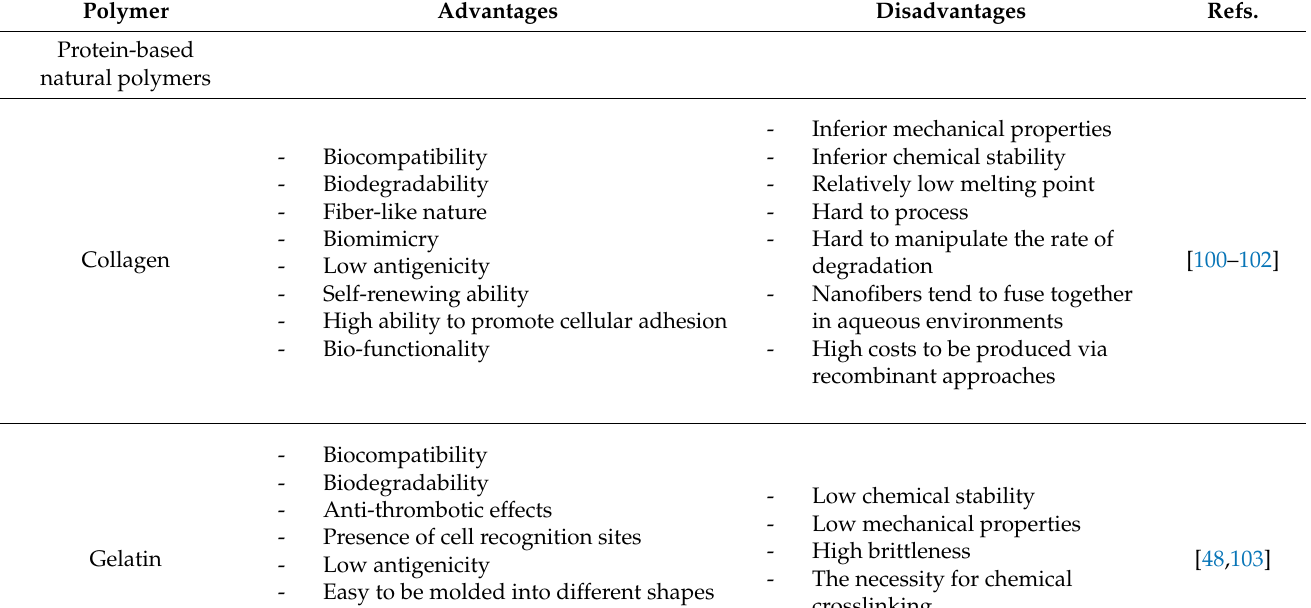
Table 1. Examples of natural polymers used as biomaterials for the production of BTE scaffolds along with their advantages and disadvantages.